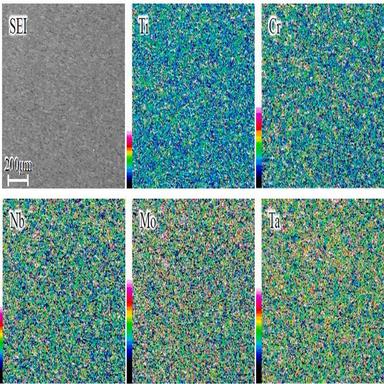
EDS maps of a sintered TiCrNbMoTa specimen (a) low magnification (b) high magnification.